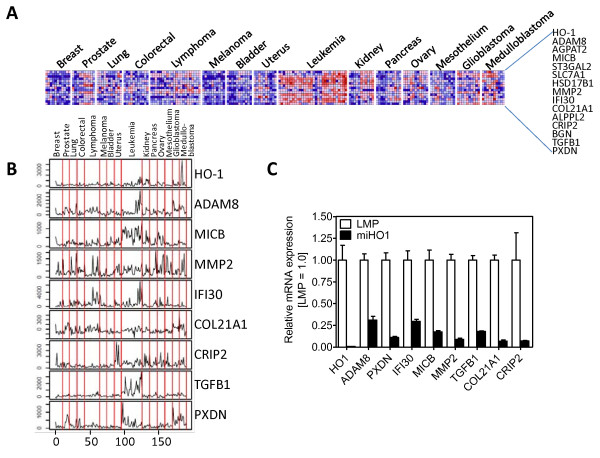
HO-1 target gene expression in 190 human tumors. (A) The heatmap shows the expression pattern of 14 HO-1 target genes including HO-1 itself in the 190 human tumors of the 14 most common cancer types included in the GCM database. Red and blue squares denote high versus low levels of expression of each individual gene normalized to its mean expression across all tumor samples, respectively. (B) Relative gene expression of 8 selected HO-1 target genes. The Y-axis displays the normalized DNA Microarray signal across 190 tumor samples (comprising the X-axis). Cancer types are shown above the plot. (C) mRNA levels were measured by qRT-PCR using the RNA samples isolated from HO-1 expressing (LMP) and HO-1 silenced (miHO-1) BeWo cells. The expression values were normalized relative to Arp. The levels of mRNA in LMP and miHO-1 cells are shown in percentage relative to LMP cells (set to 100%). Bars represent mean (+/- SEM) of three independent experiments.